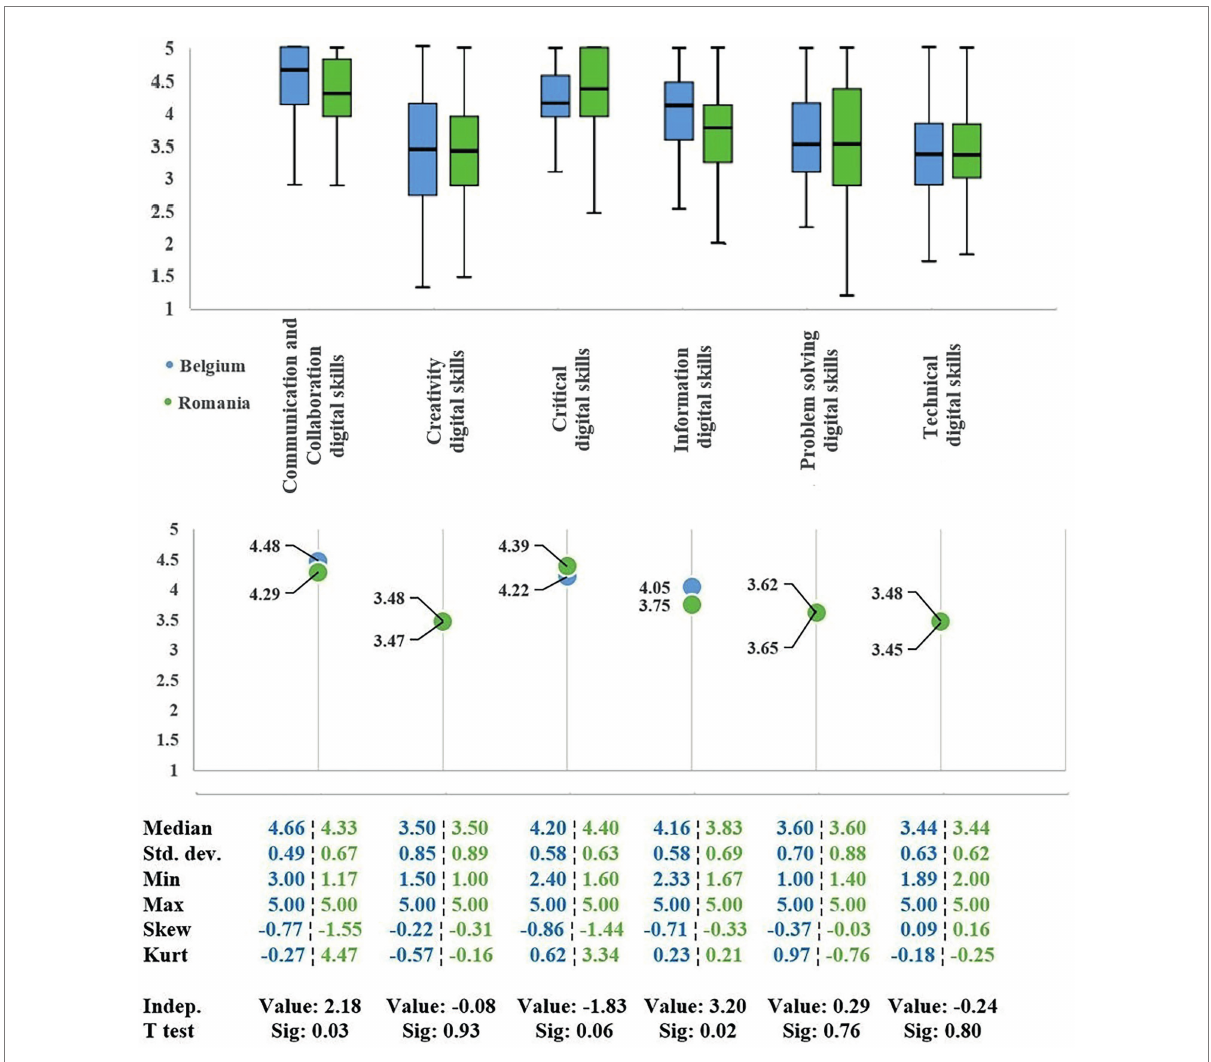
FIGURE 2 Descriptive statistics of the Digital Skills scores for Belgium and Romania. Source: authors’ calculations based on the Stata statistical analysis software.